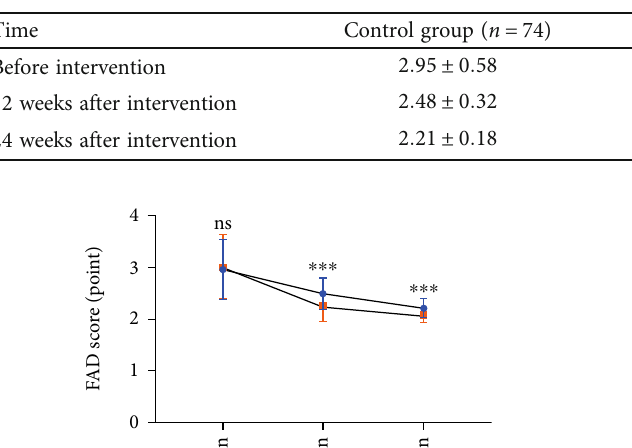
Table 5: Score of FAD (total function) between the two groups (point, (cid:1) x ± s ).